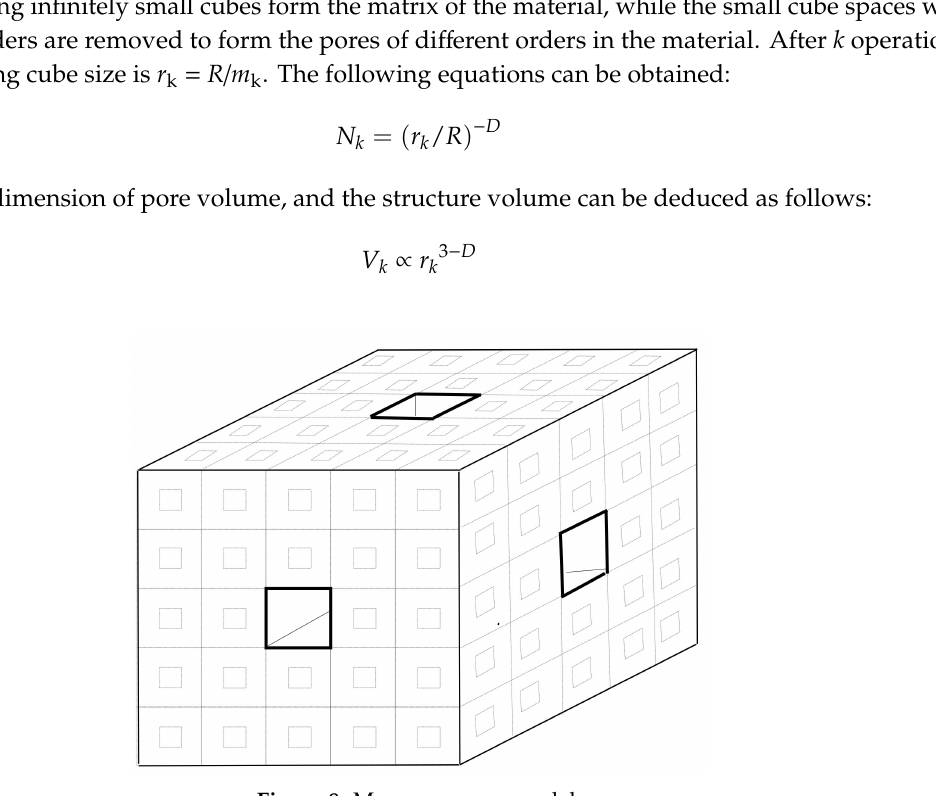
Figure 8. Menger sponge